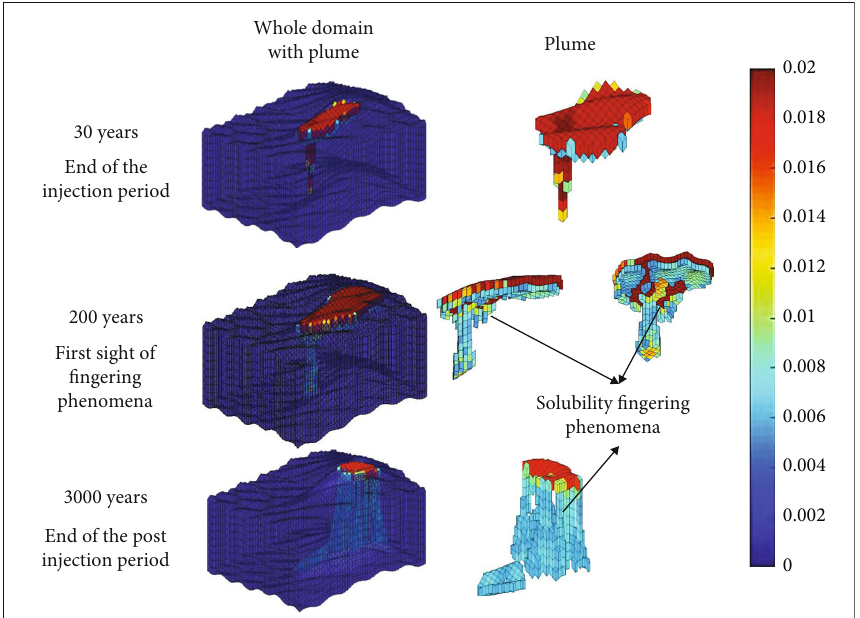
Figure 4: Solubility fi ngering phenomenon during CO CO 2 mole fraction Time variation (Years)